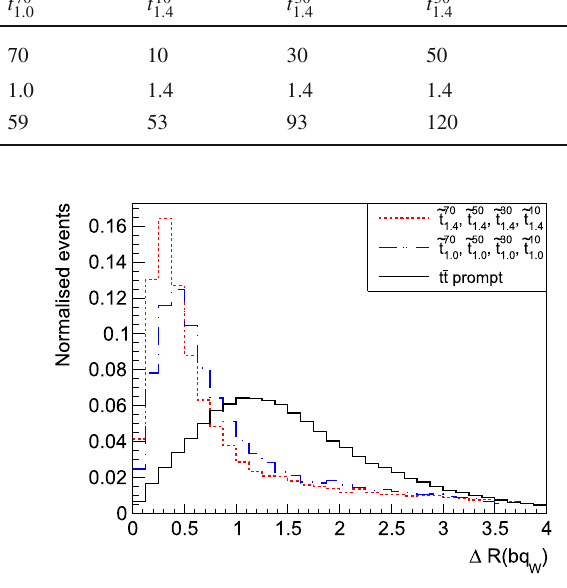
Fig. 46 Missing transverse energy MET in the stop squark ˜ t case